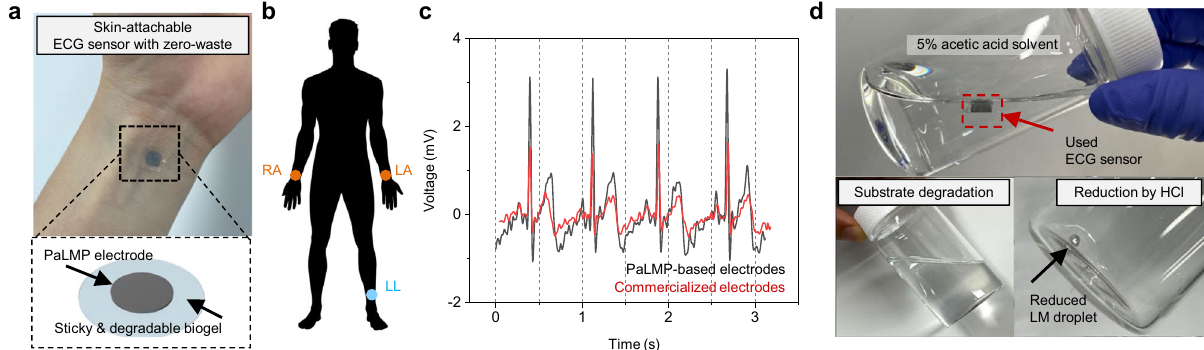
Fig. 7 PaLMP-based zero-waste ECG sensor. a Photograph image and illustration of skin-attachable ECG sensor with zero-waste. b Schematic illustration of three electrodes-based ECG monitoring. ECG sensors are attached on the right arm (RA), left arm (LA), and left leg (LL) c Real-time ECG monitoring with PaLMP-based electrodes and commercialized electrodes. d Photograph image of used ECG sensor disposal process. PaLMP-based electrodes are reduced into bulk LM and the biogel-based substrate is fully